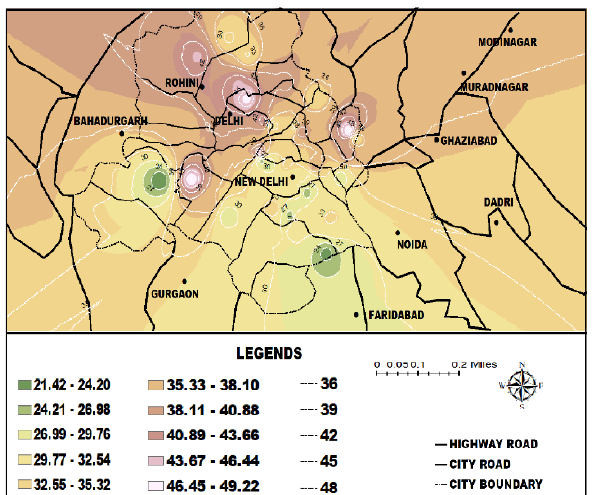
Figure 7. Air quality map of Delhi August monthly average based on PM2.5 (µg/m 3 ).